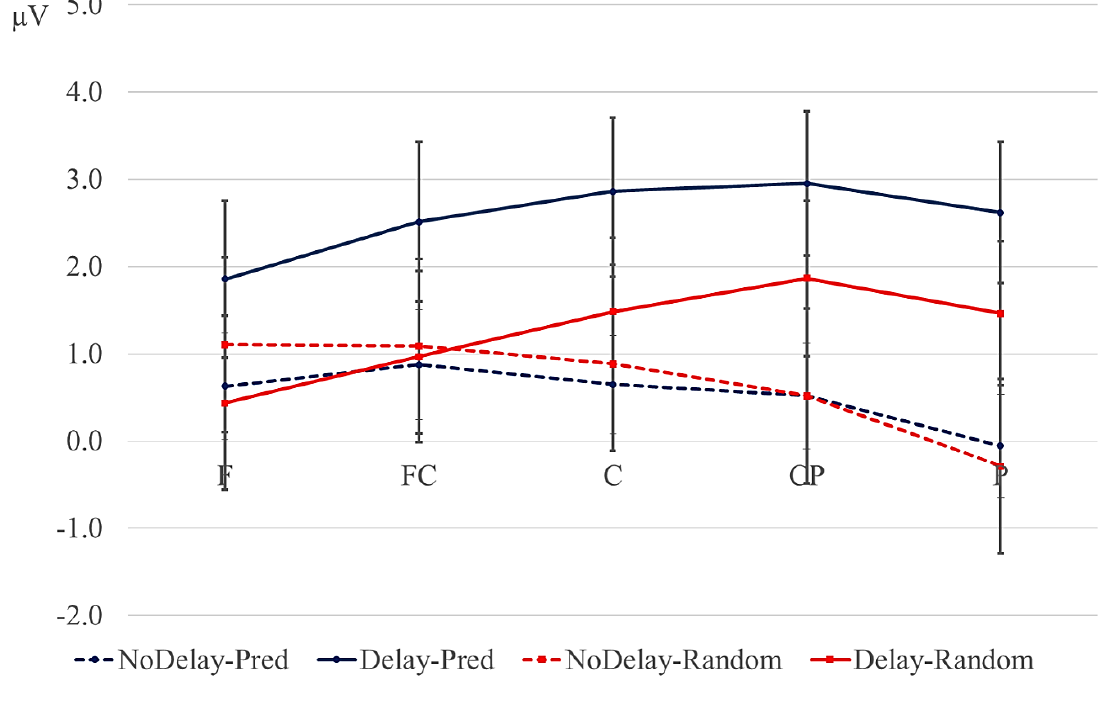
Figure 4. Mean amplitude (µV) between 180 and 280 ms from the onset of the post-delay letter, for the lateral positions, collapsed over hemisphere (error bars are standard errors). Blue lines: predictive sequences (Pred); red lines: random sequences; solid lines: delay conditions; dotted lines: conditions without a delay. F: frontal; FC: fronto-central; C: central; CP: central-parietal; P: parietal.